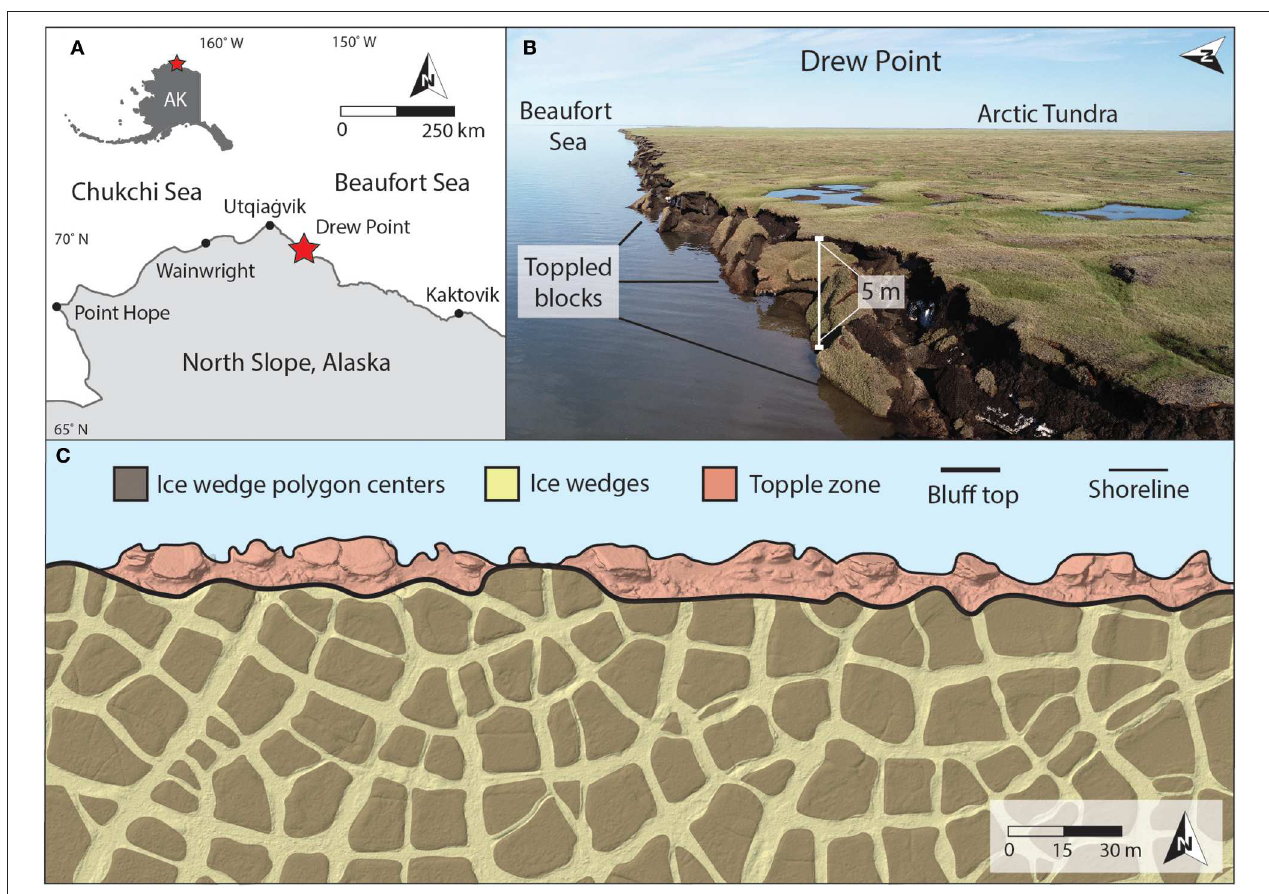
FIGURE 1 | (A) Location of the Drew Point study area (red star) along the north coast of Alaska, USA. (B) Oblique aerial view acquired by unmanned aerial vehicle (UAV) showing toppling mode block failure that is typical along the coastline at Drew Point. (C) UAV orthophoto mosaic showing the permafrost terrain configuration at Drew Point consisting of ice wedges, ice wedge polygon networks, and the topple zone. Roughly 75% of the block failures in this example occurred along an ice wedge, whereas 25% occurred in an ice wedge polygon